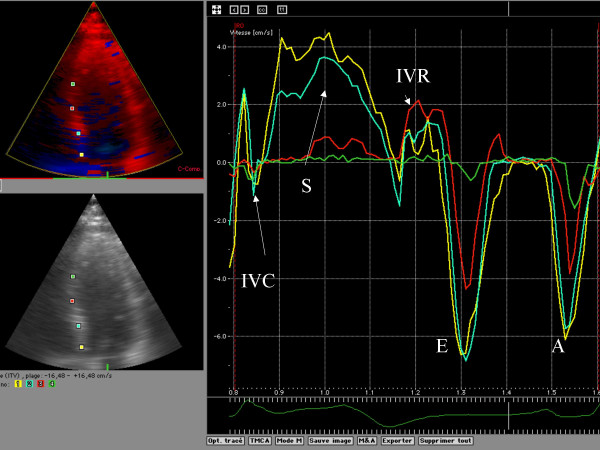
Example of a DTI curve analysis. It was manually positioned a region of interest (ROI) at the level of the mitral annulus and three others in the 3 segments of each wall (following the ASE left ventricular segmentation) IVC: peak of velocity recorded at the isivolumic contraction time S: peak of velocity recorded in systole IVR: peak velocity recorded in isvolumic relaxation time E: peak velocity in early diastole A: peak velocity in end-diastole